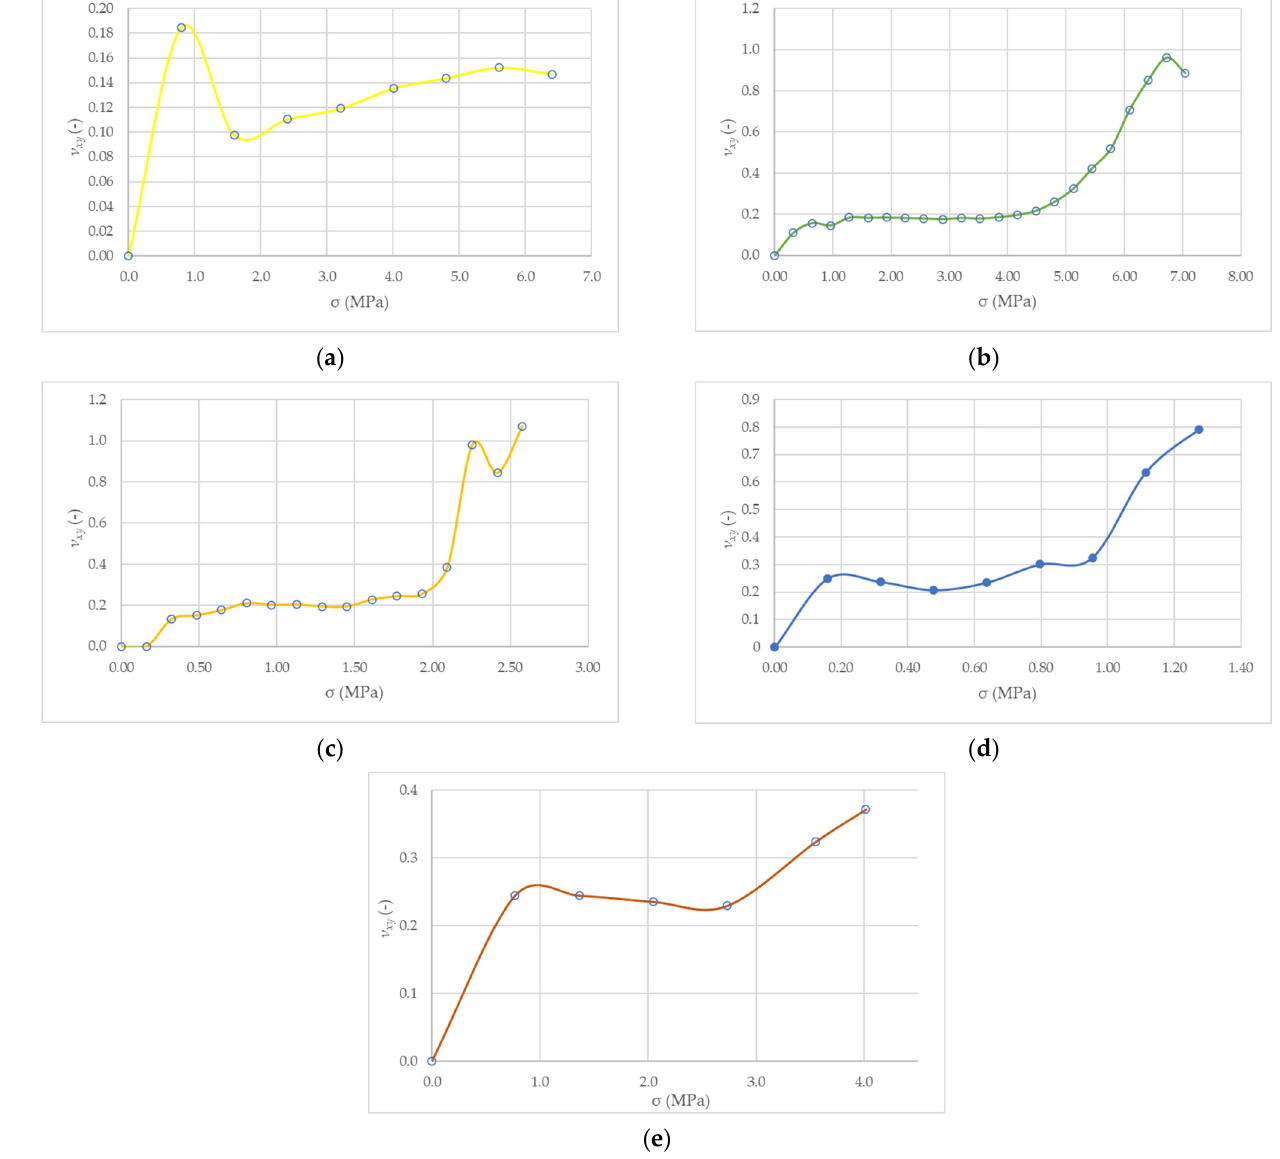
Figure 11. Representative Poisson’s ratio – stress curves of tested wall panels at different joint angles ( a ) θ = 0°, ( b ) θ = 22.5°, ( c ) θ = 45°, ( d ) θ = 67.5°, ( e ) θ = 90°.